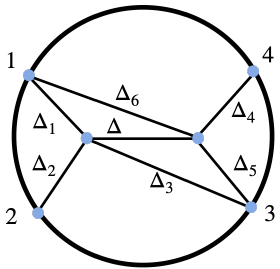
Figure 9 . Exchange Witten diagram with two bound states (type